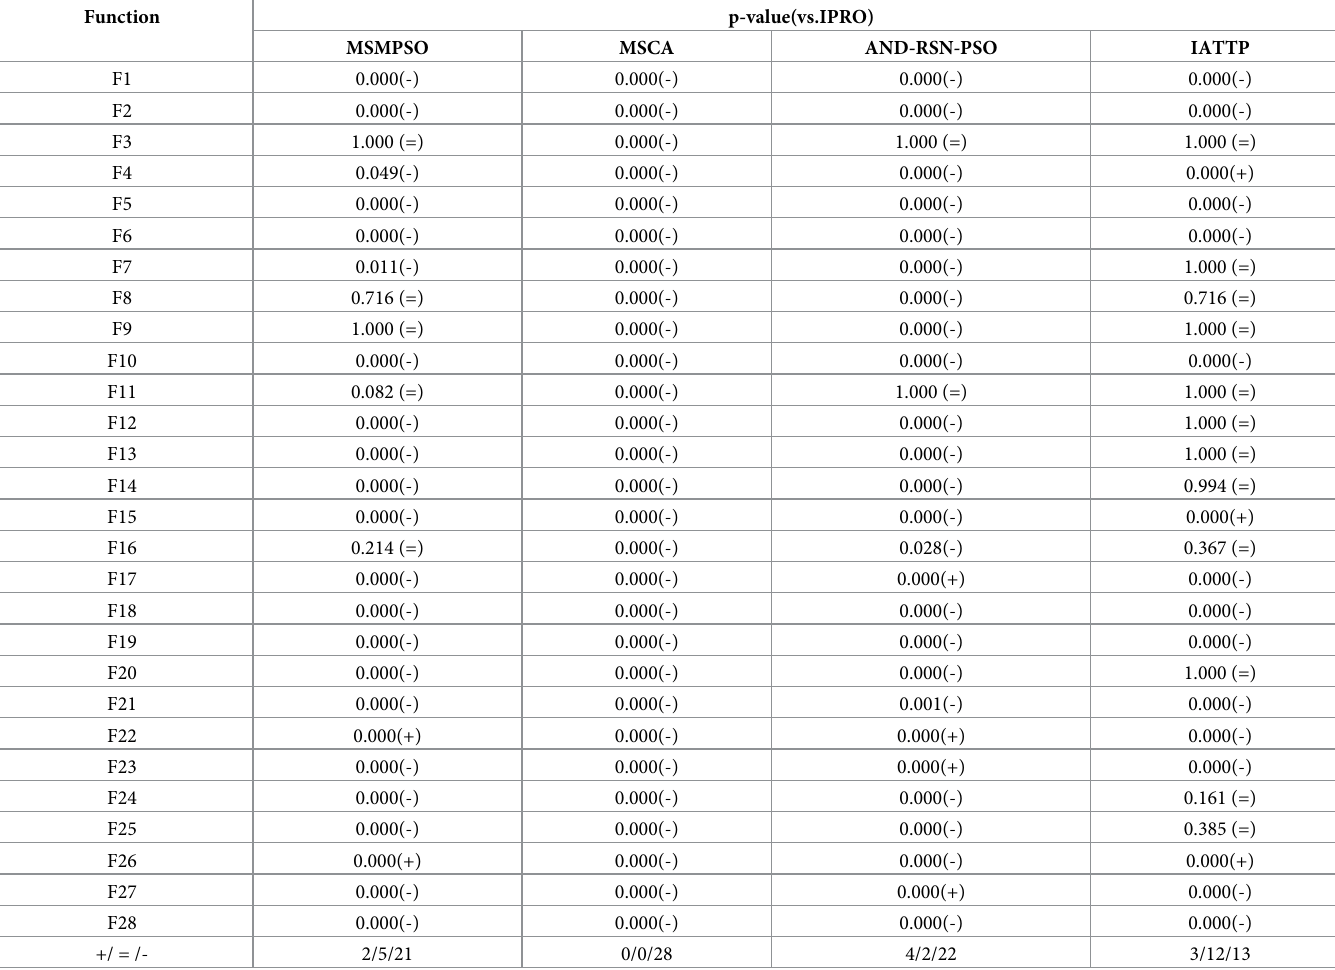
Table 8. Wilcoxon rank sum test between IPRO and each comparison algorithm on CEC2013 test suite. Function